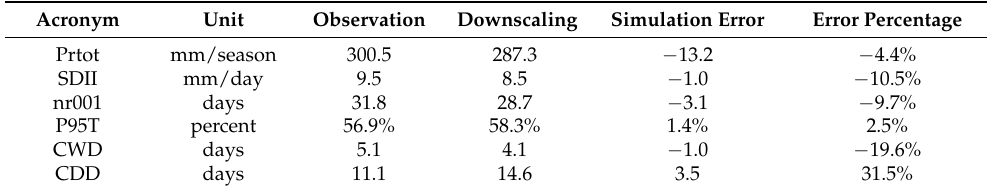
Table 2. Comparison of precipitation downscaling results with observed values (observations and simulations were averaged at 45 stations, respectively, and then the errors were calculated). Acronym Unit Observation Downscaling Simulation Error Error Percentage Prtot mm/season 300.5 287.3 − 13.2 − 4.4% SDII mm/day 9.5 8.5 − 1.0 − 10.5% nr001 days 31.8 28.7 − 3.1 − 9.7% P95T percent 56.9% 58.3% 1.4% 2.5% CWD days 5.1 4.1 − 1.0 − 19.6% CDD days 11.1 14.6 3.5